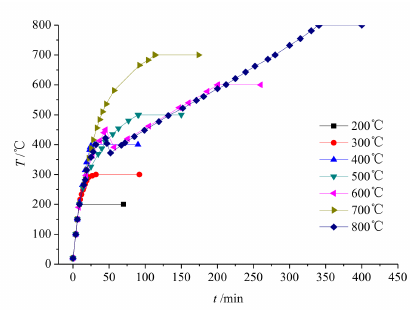
Figure 3. Heating curves.